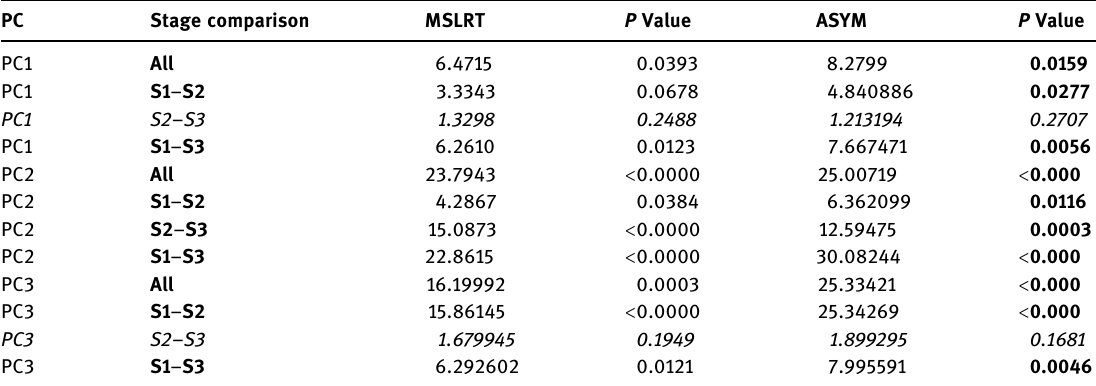
Table 3: CV equality test results across three stages among PC1 – 3. Italicized comparisons denote non - signi fi cant values. Bold values denote statistically signi fi cant values (< 0.05